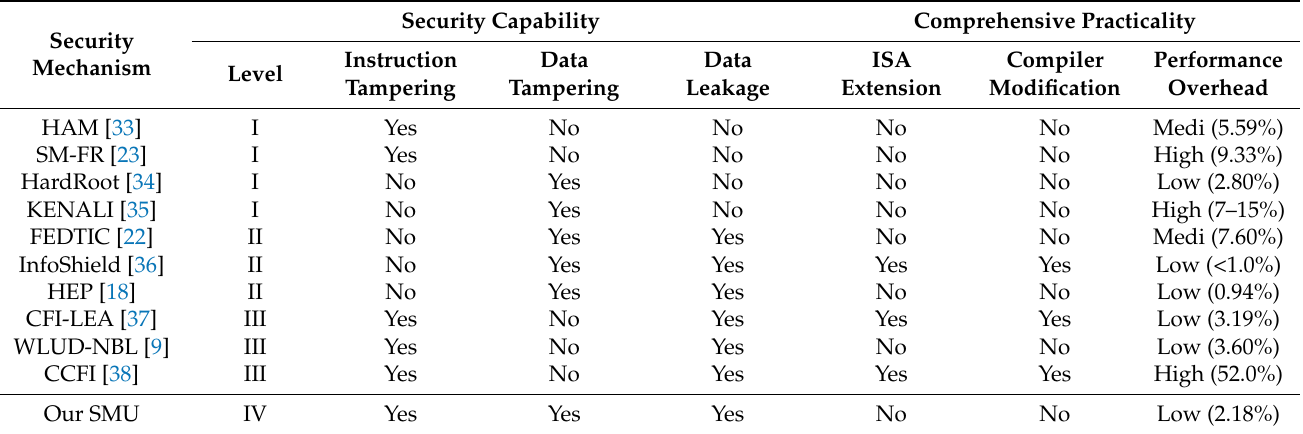
Table 4. Comparison of security capability and comprehensive